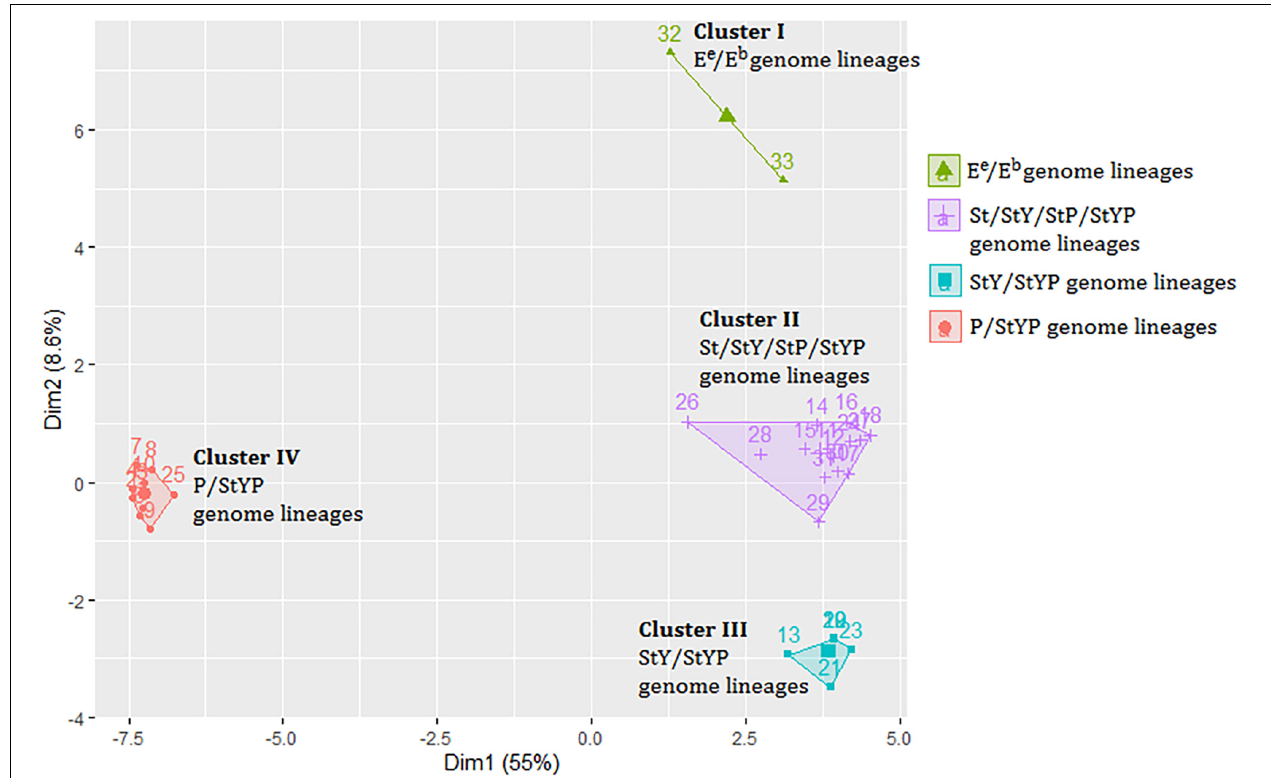
FIGURE 3 | The cluster plot based on a distance matrix of Kengyilia species and its close relatives. Numbers represent lineages listed in Supplementary Table 3 .